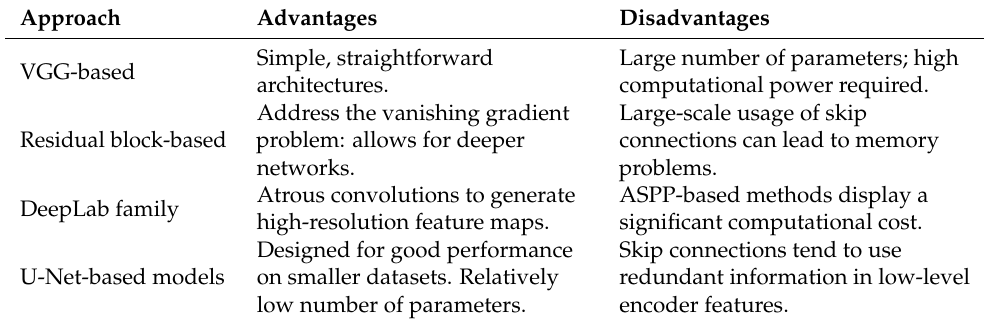
Table 1. Overview of the advantages and disadvantages of the discussed